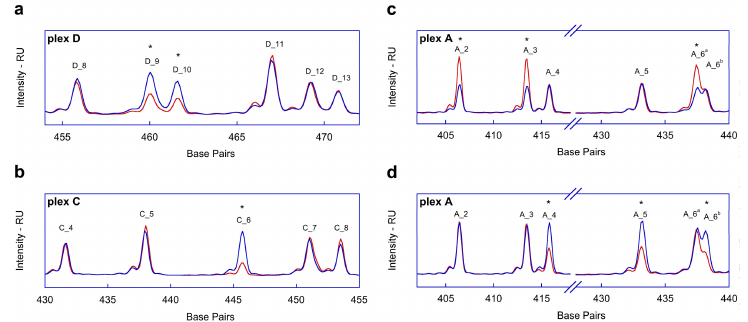
Figure 2. Detailed views of the fragment analysis profiles (red lines) using in house script of one sample carrying a deletion of a region of 2664 base pair in BRCA1 , as an example ( a , b ), and the Sample 5 ( c , d ) against True Negative-CNV electropherogram profile (blue line). ( a ) Deletion of exon 5 and exon 7 of BRCA1 within plex D, herein reported with an asterisk and labeled as D_9 and D_10, respectively. ( b ) Deletion of exon 6 on BRCA1 within plex C, herein reported with an asterisk and labeled as Amplicon C_6. ( c , d ) Profiles of a subset of amplicons from plex A, after gene normalization on Sample 5 data (red lines): ( c ) normalization of BRCA2 amplicons peak heights (reference amplicons A_4, A_5, A_6 b ) shows that BRCA1 peaks are nearly twice those expected (reference pattern, blue line); while ( d ) applying normalization of BRCA1 amplicon peak heights (amplicons A_2, A_3, A_6 a ), all peaks belonging to BRCA2 are halved against reference (blue line).